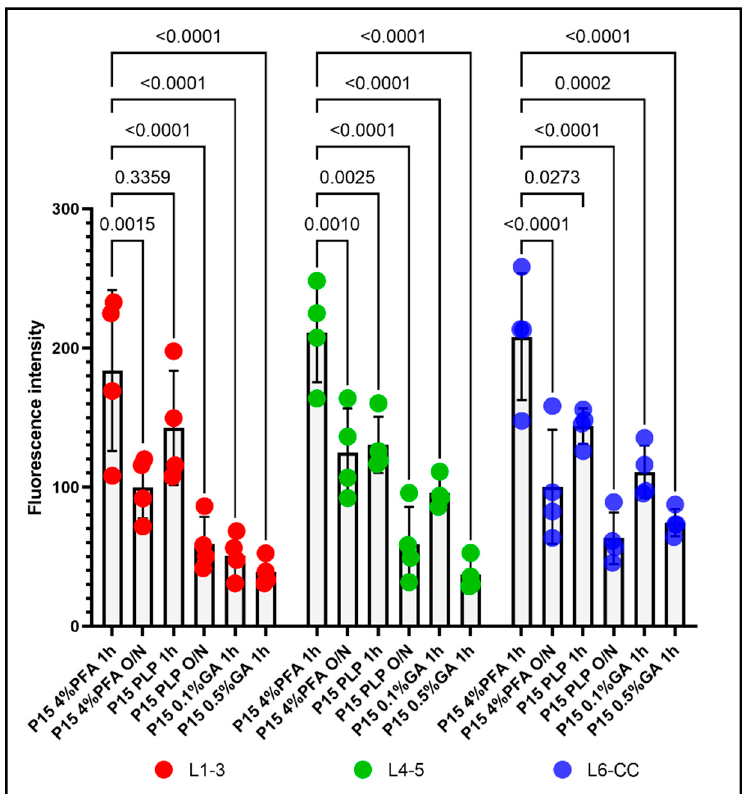
Figure 2. The effects of the different fixation protocols on PDGFR α immunofluorescence intensities at P15, grouped by different layers. Left: PDGFR α immunofluorescence intensity in L1–3 after 4%PFA 1 h, 4%PFA O/N, PLP 1 h, PLP O/N, 0.1%GA 1 h, and 0.5%GA 1 h. Middle: PDGFR α immunofluorescence intensity in L4–5 after 4%PFA 1 h, 4%PFA O/N, PLP 1 h, PLP O/N, 0.1%GA 1 h, and 0.5%GA 1 h. Right: PDGFR α immunofluorescence intensity in L6-CC after 4%PFA 1 h, 4%PFA O/N, PLP 1 h, PLP O/N, 0.1%GA 1 h, and 0.5%GA 1 h. Two-way ANOVA followed by Tukey’s multiple comparisons test. n = 4 for each group. Comparison among fixatives: F(5, 54) = 46.37, p < 0.0001. Comparison among layers: F(2, 54) = 3.350, p = 0.0425.